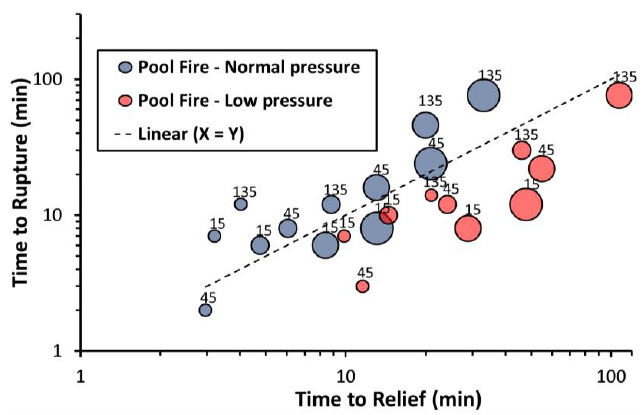
Figure 6. Grouped results for the pool fire scenario in terms of vessel diameter, design pressure and operating pressure.